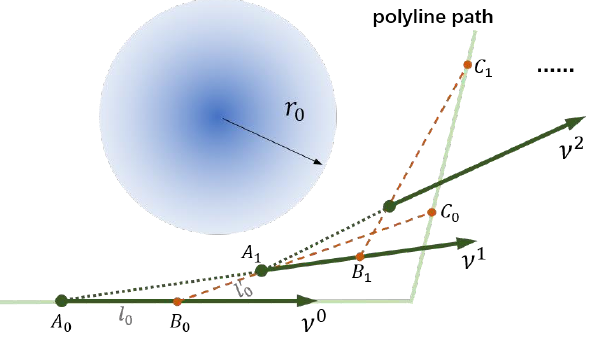
Figure 10. Illustration of path smoothing procedures.